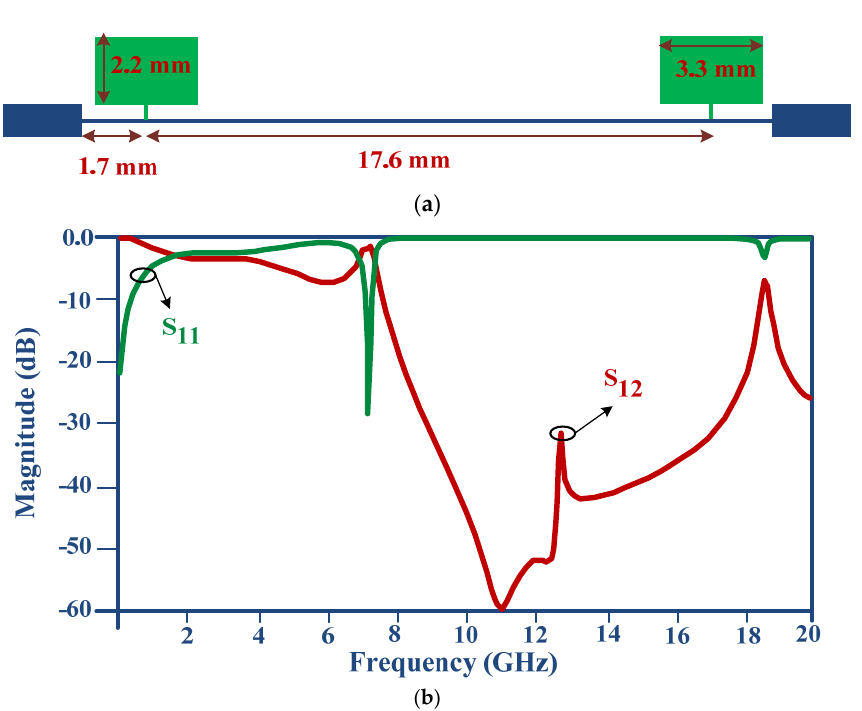
Figure 9. The square-shape attenuator resonator ( a ) structure and ( b ) its frequency response.